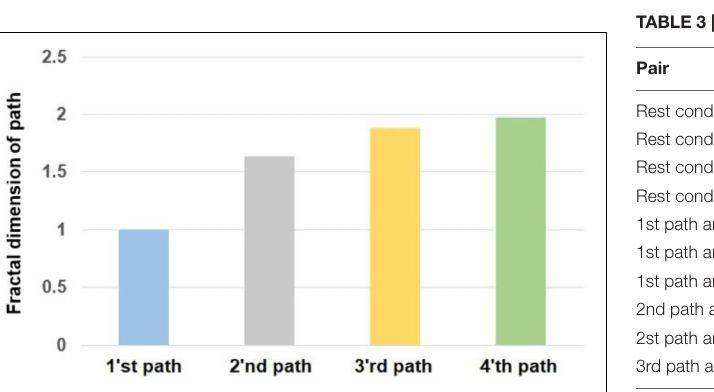
FIGURE 4 | The fractal dimension of different paths.